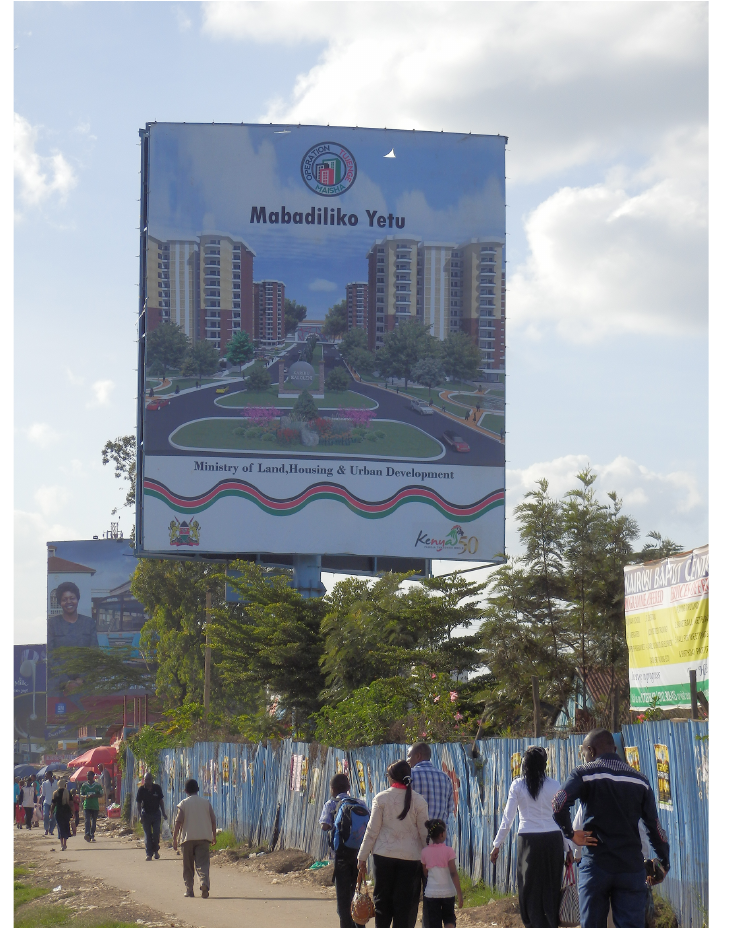
Figure 1. The billboard showing the architects’ rendering of a ‘New Kaloleni’. Jogoo Road, Nairobi, December 2013. Photo by the